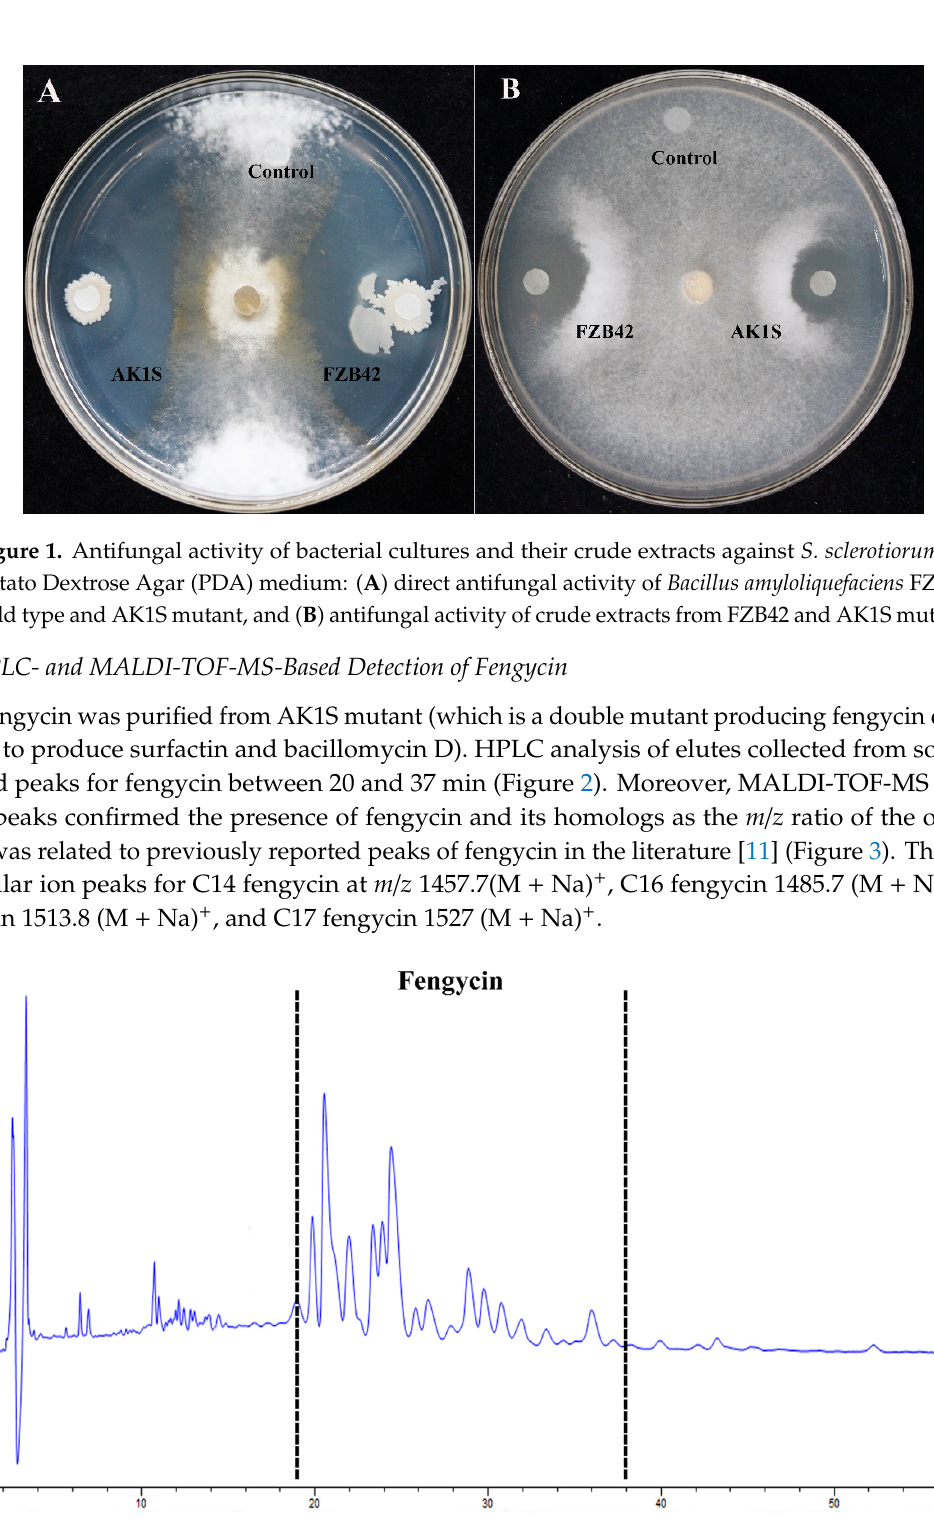
Figure 2. HPLC chromatogram of fengycin extracted and purified from AK1S mutant.